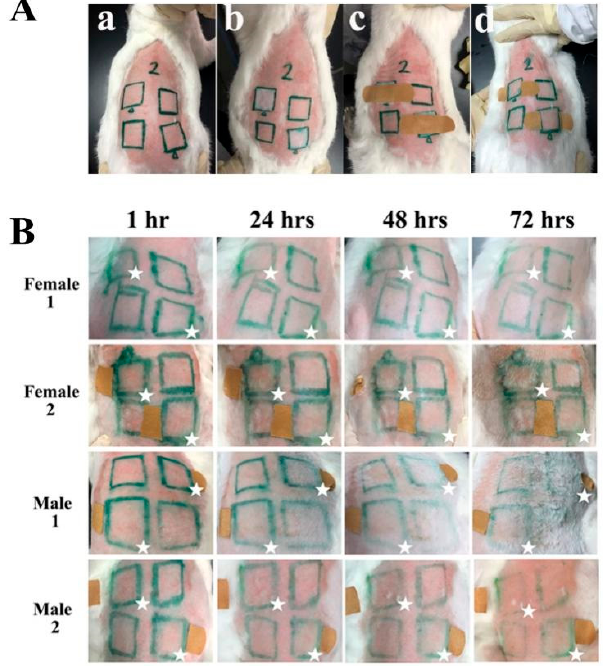
Figure 3. Skin irritation test of THRC dressing on rabbits. ( A ) Photos of the experimental process. The shaved rabbit skin was divided into different areas ( a ), and THRC dressings were applied on two test sites, leaving the other two sites as a control ( b ). With bandage fixation, treatments of THRC dressing were performed for 4 h ( c ), and then the dressings were removed and quantitatively scored for erythema and edema ( d ). ( B ) The images of four rabbits (Female 1, Female 2, Male 1, and Male 2) in the skin irritation test at different time intervals (1 h, 24 h, 48 h, and 72 h). The test areas are marked with ☆ . Table 1. Scores of edema and erythema of control (Con) and test (Test) sites of four rabbits at various time intervals.